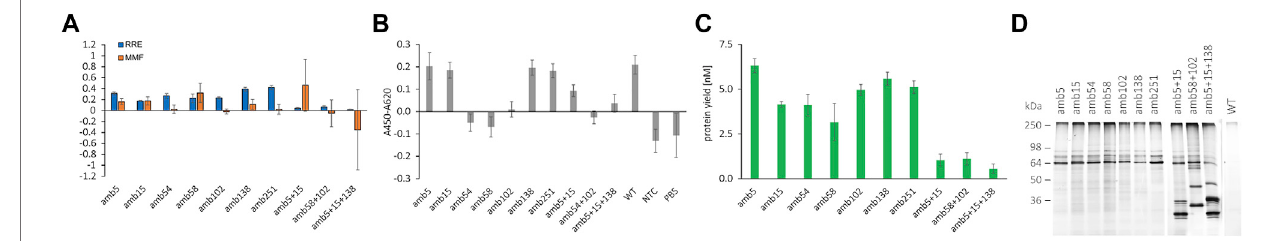
FIGURE 5 | Quanti fi cation of RFP-PNT-GFP amber suppression with different ncAA incorporation sites, functional analysis by indirect ELISA, and conjugation to DyLight ™ 650-Phosphine. (A) RRE and MMF for different ncAA positions in RFP-PNT-GFP extracted from SN2 fraction. (B) Functionality of 100 pM of the RFP-PNT- GFP variants containing ncAAs extracted from SN2 fraction by indirect ELISA (OD450-OD620 signal with coated EGFR subtracted by OD450-OD620 signal without coated EGFR). (C) ProteinyieldoffulllengthproductintheSN2fraction,calculatedbasedonFAMsignalbyusingtheformulain Figure3B . (D) In-gel fl uorescence ofSDS-PAGEafterconjugationtoDyLight ™ 650-PhosphineforRFP-PNT-GFPextractedfromSN2fractioncontainingncAAsatdifferentsites.Thegreenarrowdepicts the full-length product. Mean values are derived from triplicates and their standard deviation is plotted as error